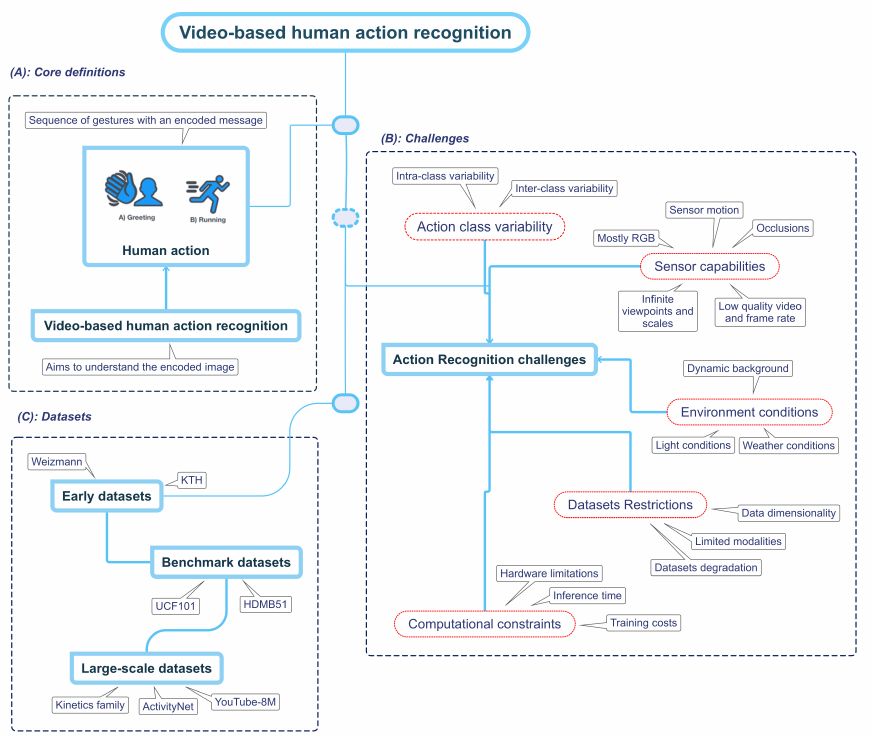
Figure 1. Video-based human action recognition overview. Part ( A ) represents human action; we instinctively associate a sequence of gestures with an action. For example, we might think of the typical hand wave when we think of the action greeting. On the contrary, imagining a person running will create a more dynamic scene with movement centered on the legs. Part ( B ) explains current challenges in the field, and Part ( C ) shows the relevant dataset